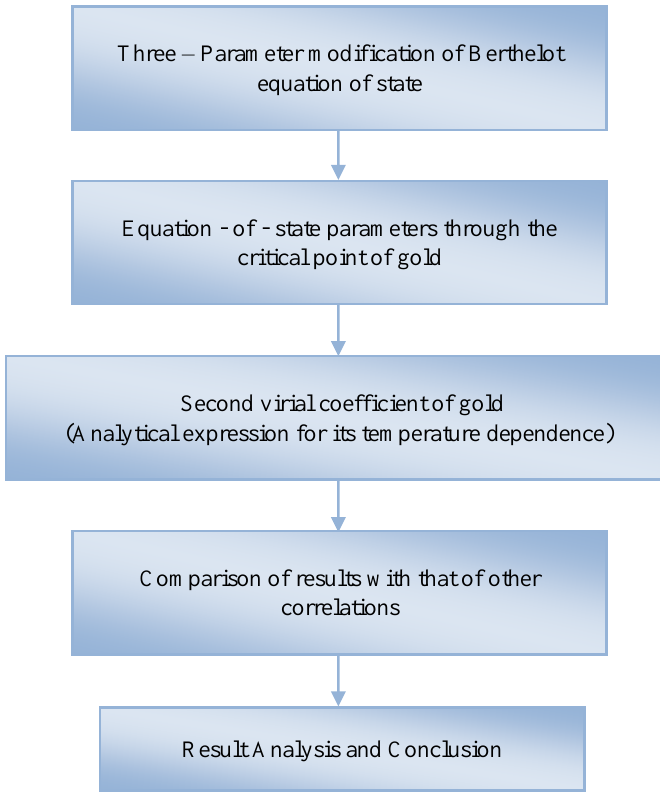
Figure 1. Flowchart of the research